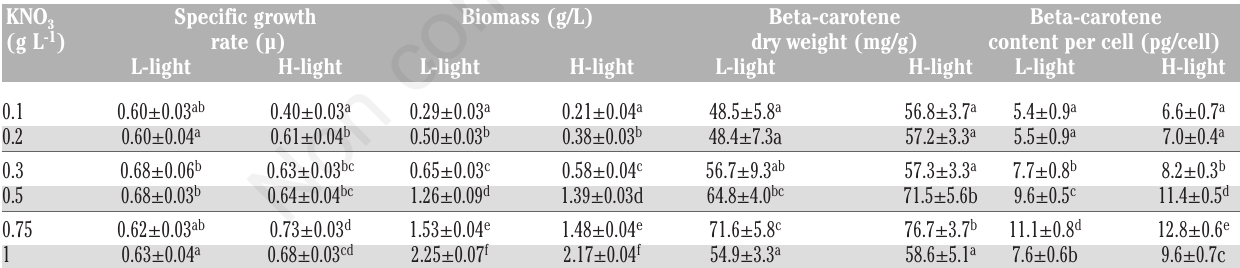
concentration and light intensity. 3